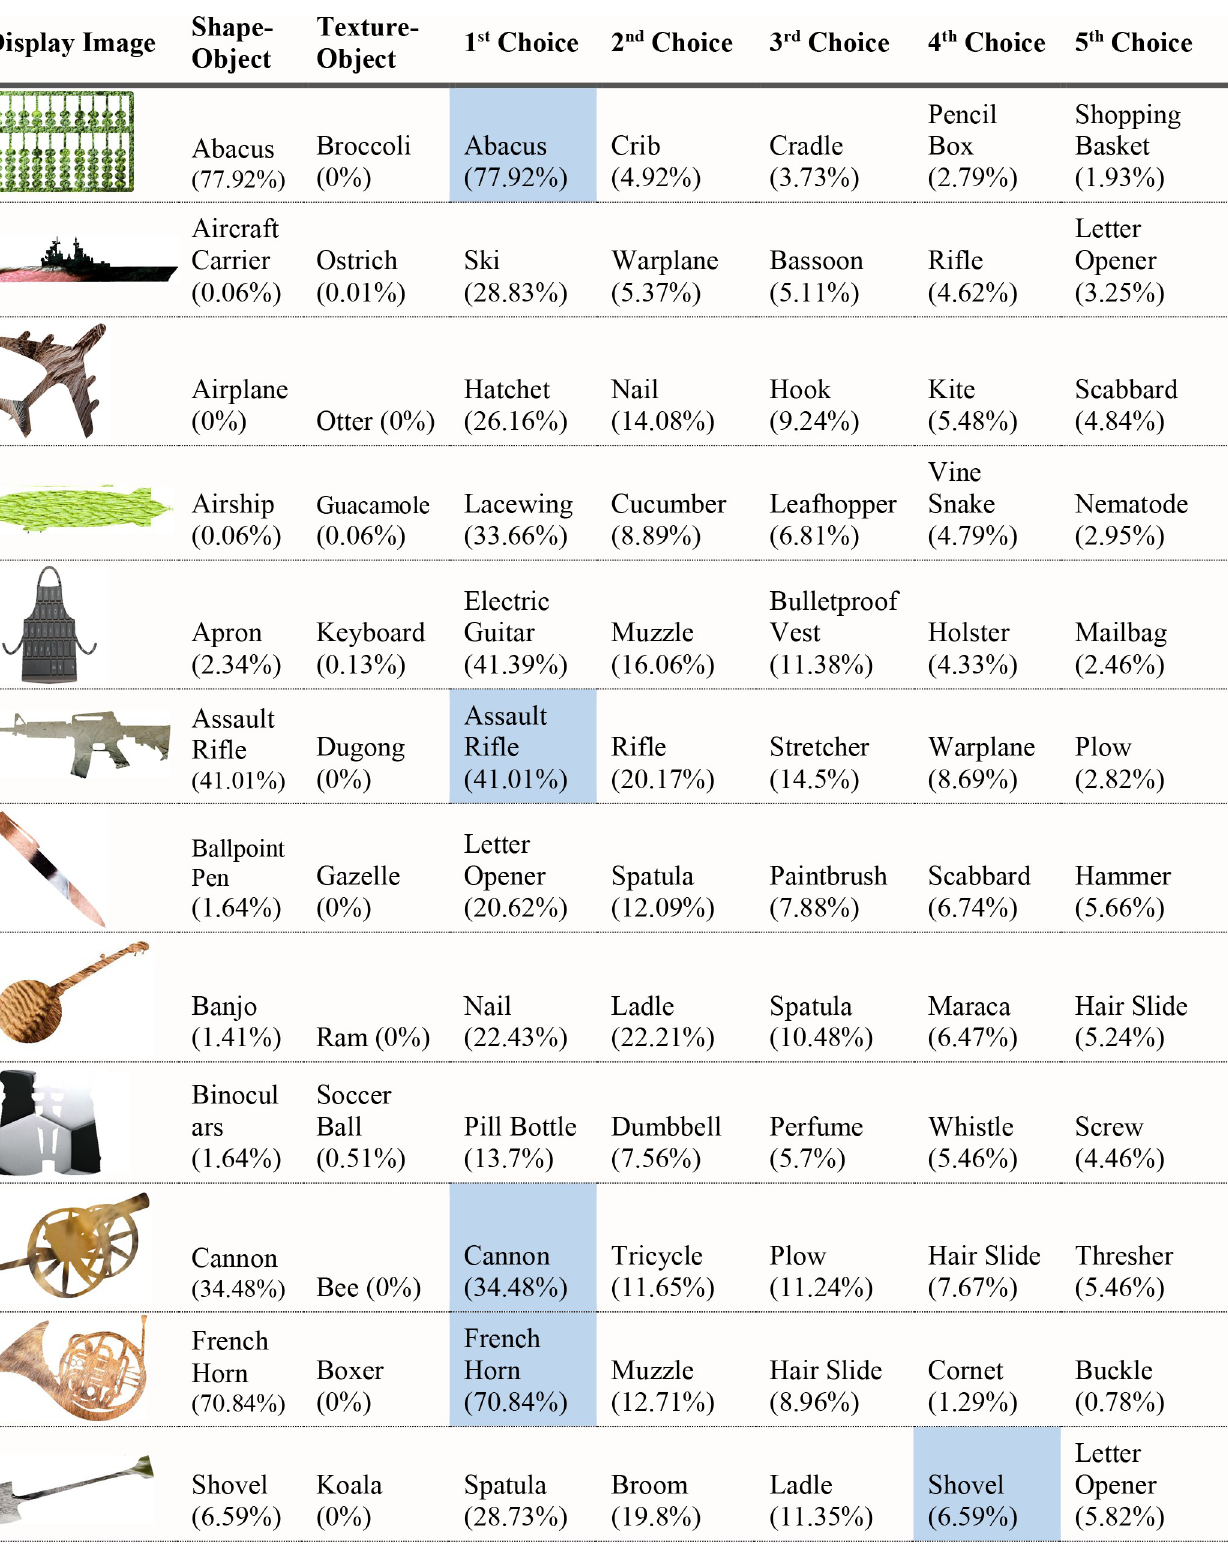
PLOS Computational Biology | https://doi.org/10.1371/journal.pcbi.1006613 December 7,